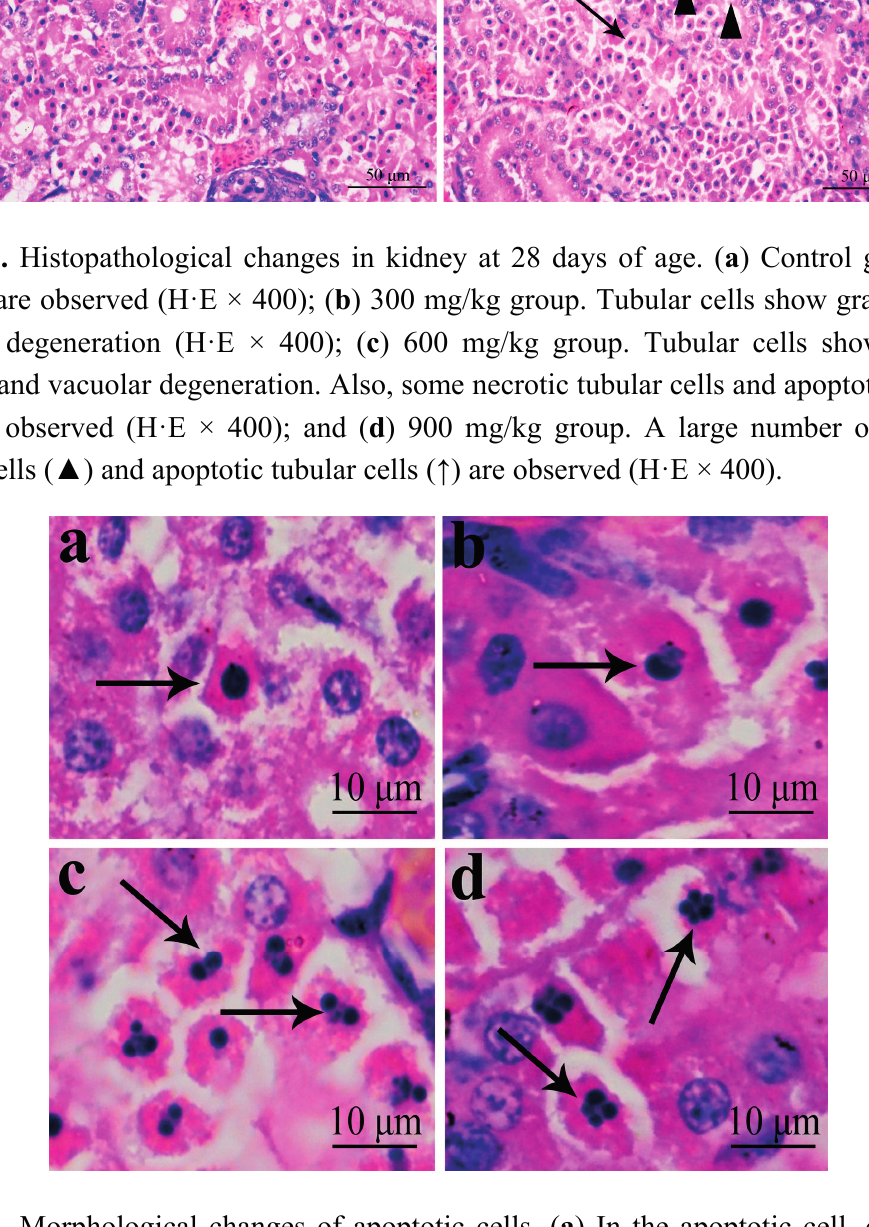
Figure 4. Morphological changes of apoptotic cells. ( a ) In the apoptotic cell, cytoplasm was intensely eosinophilic, and nucleus is shrunken and dense ring-shaped ( ↑ ). (H·E × 1000); and ( b ) In the apoptotic cell, nucleus is crescentic ( ↑ ). (H·E × 1000); ( c ) and ( d ) In the apoptotic cells, nuclei are cracked into two or multiple apoptotic bodies ( ↑ ). (H·E ×